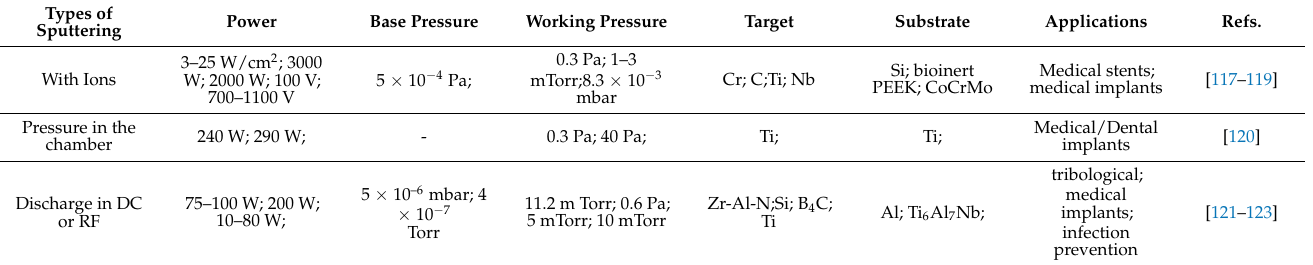
Table 5. Significant examples of biomaterials deposited using the magnetron sputtering